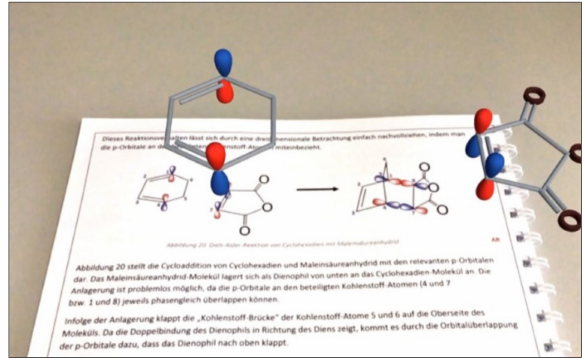
Figure 4. Example of the App ARC in use (3D animation of a chemical